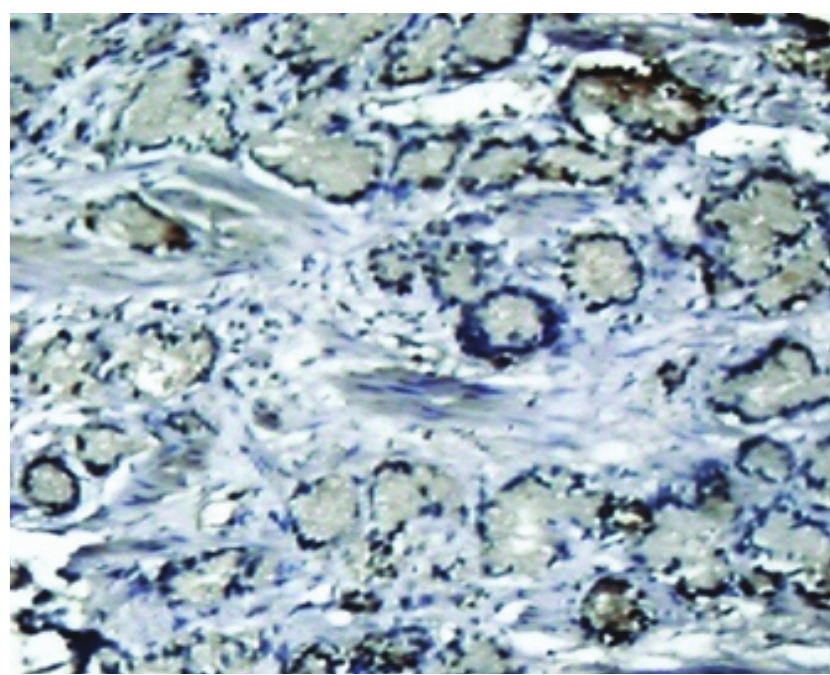
Figure 2: Prostatic adenocarcinoma with rounded glands showing strong nuclear Cyclin D1 staining, grade 3+.